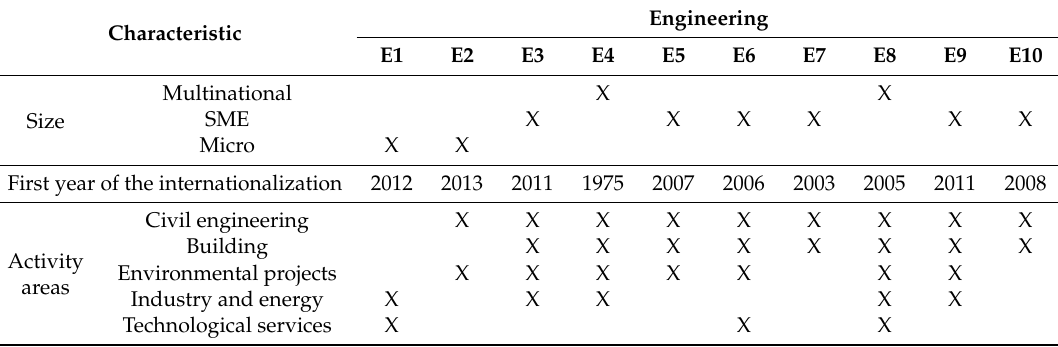
Table 1. Characteristics of the companies covered by the selected sample. SME: small and medium-sized